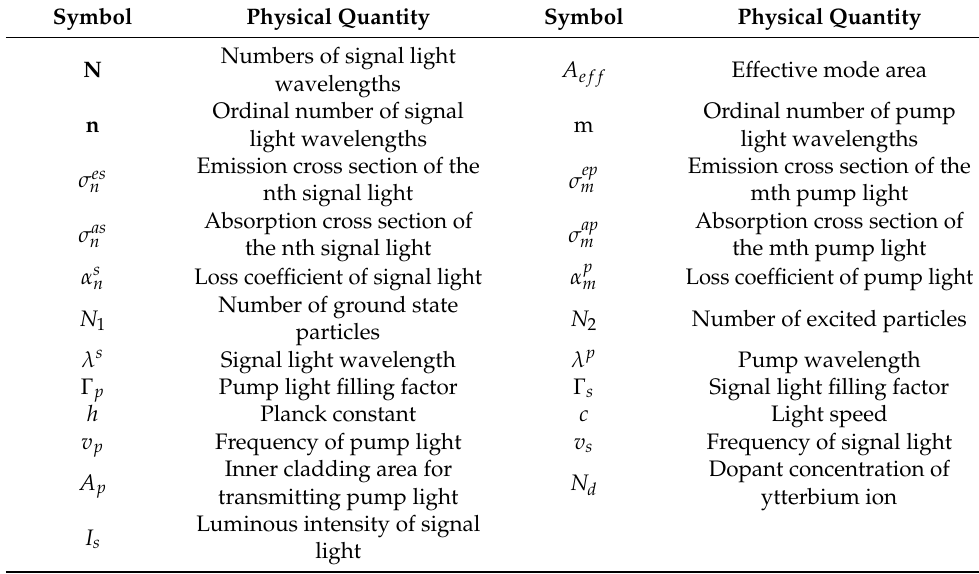
Table 1. The physical meaning of symbols in rate